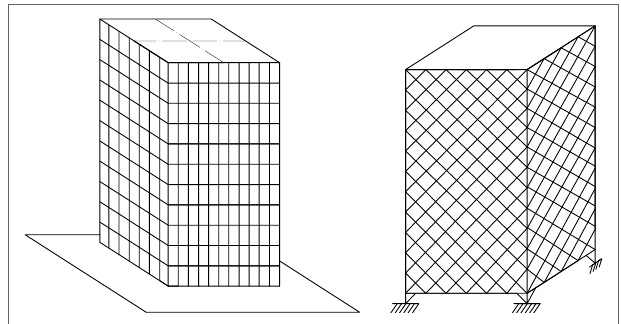
FigURe 7 | Structural systems for tall buildings: (from the left) framed tube [adapted from Smith et al. (1991)]; braced tube [adapted from Smith et al. (1991)].